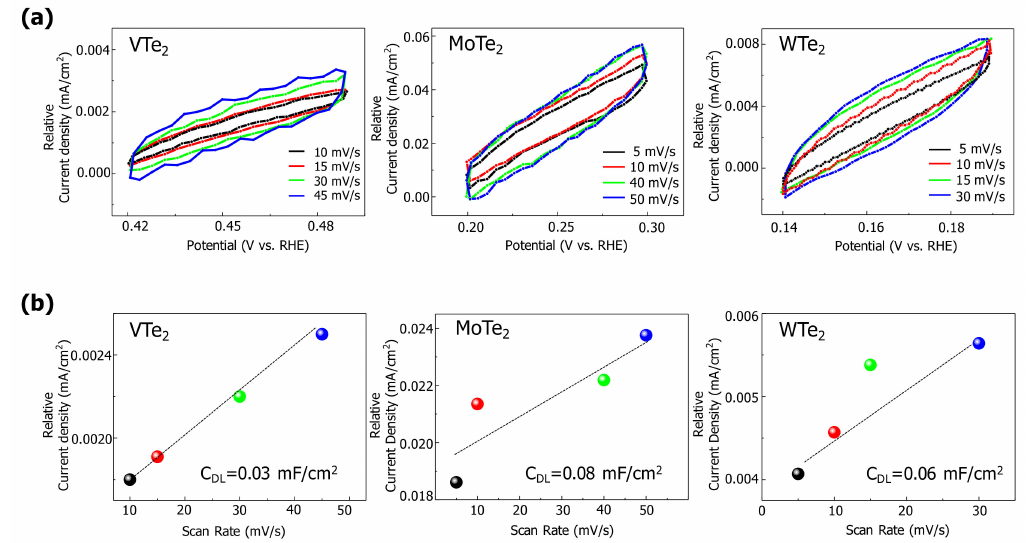
Figure 3. ( a ) Cyclic voltammetry (CV) curves at di ff erent scan rates and ( b ) capacitive current as a function of scan rate of VTe 2 , MoTe 2 , and WTe 2 .